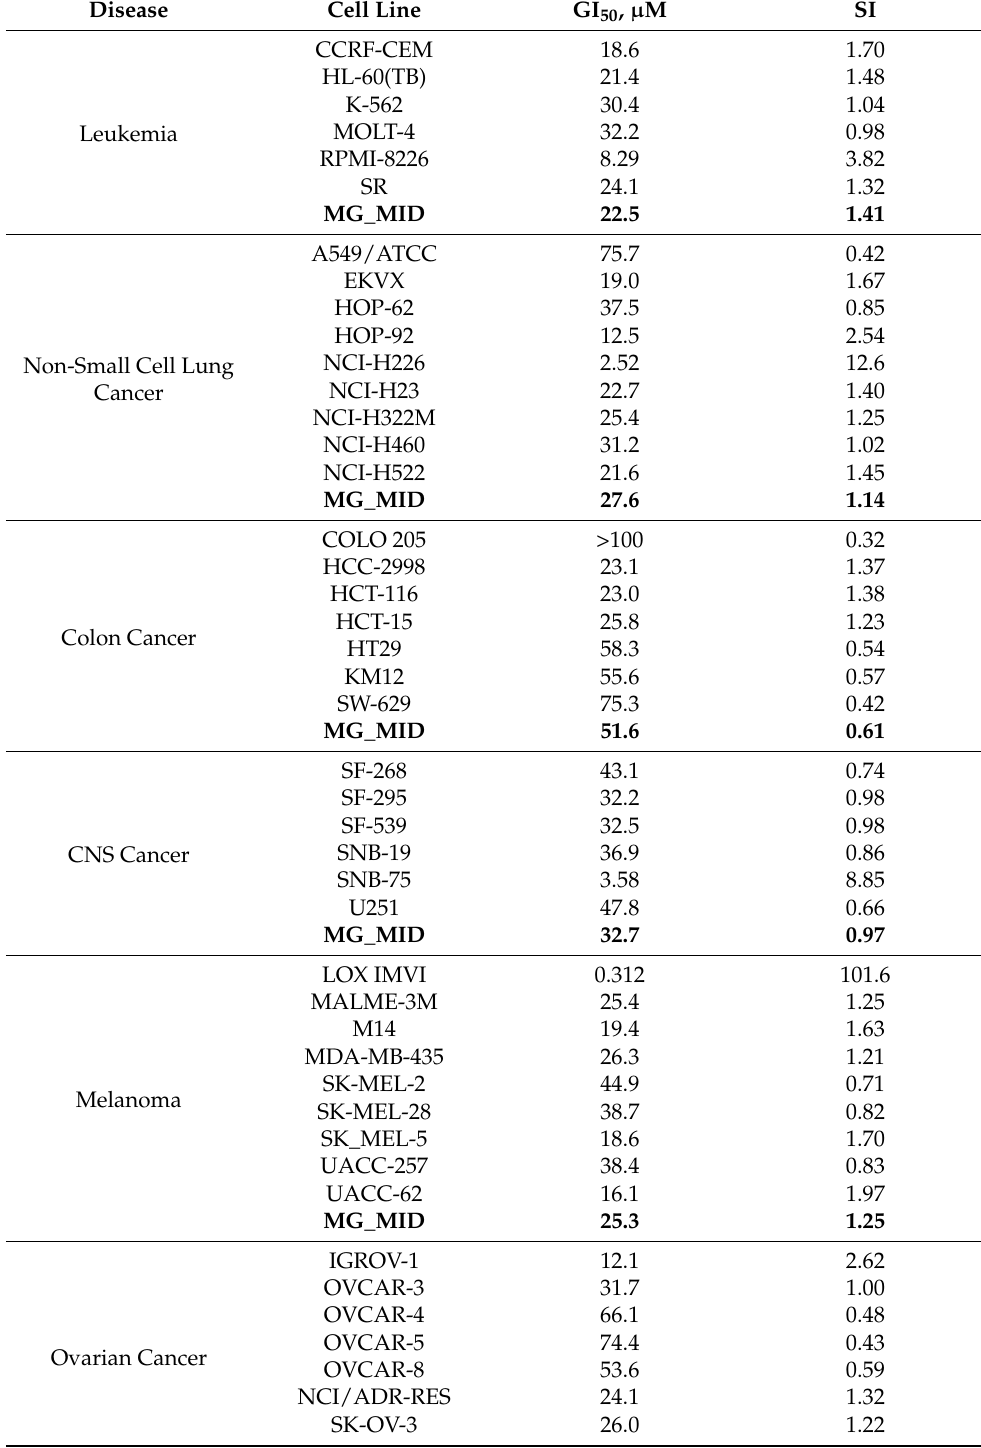
Table 4. Influence of Compound 4 on the Growth of Individual Tumor Cell